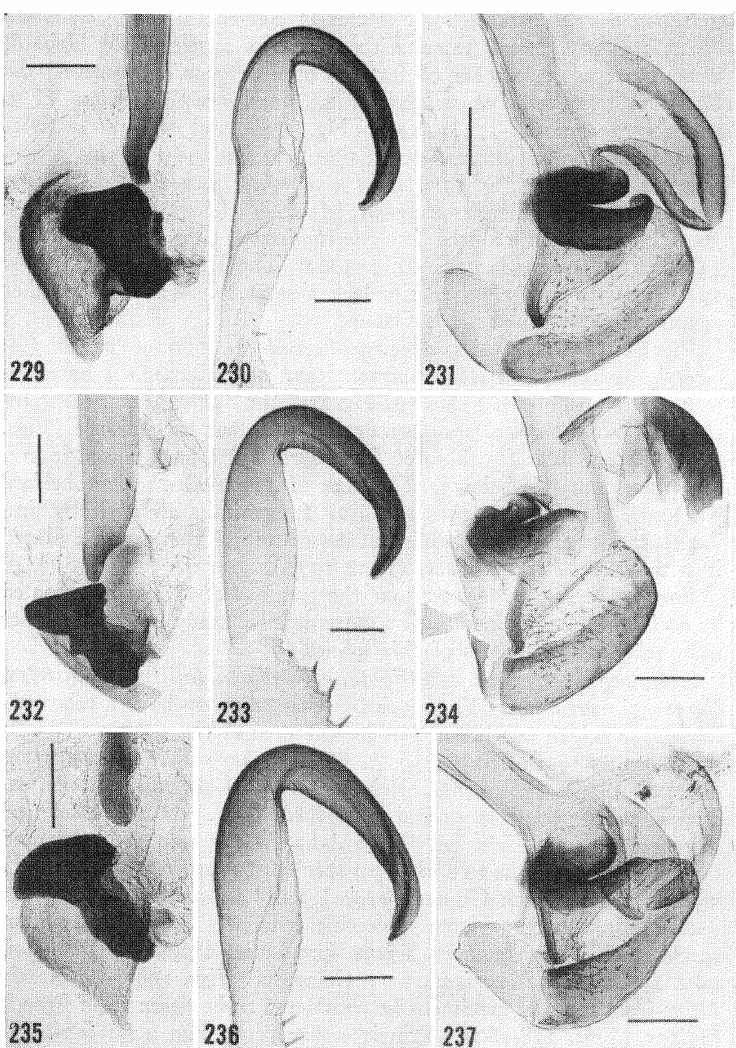
Figs. 229-237. Cockroach male genitalia. Epilampra sp. 229-231. (44 ANSP). Provineia Sara, Dep. Santa Cruz, Bolivia (det. as E.-conferta by Hebard). 232-234. (43 ANSP). Parintins, Pardi, Brazil (det. as E. conferta by Rehn). 235-237. (76 USNM). Serra do Navio, Territ. Amapi, Brazil (det. E. conferta by Albuquerque; recorded in Albuquerque and Gurney, 1962, p. 242). (see discussion on page 443). (scale 0.2